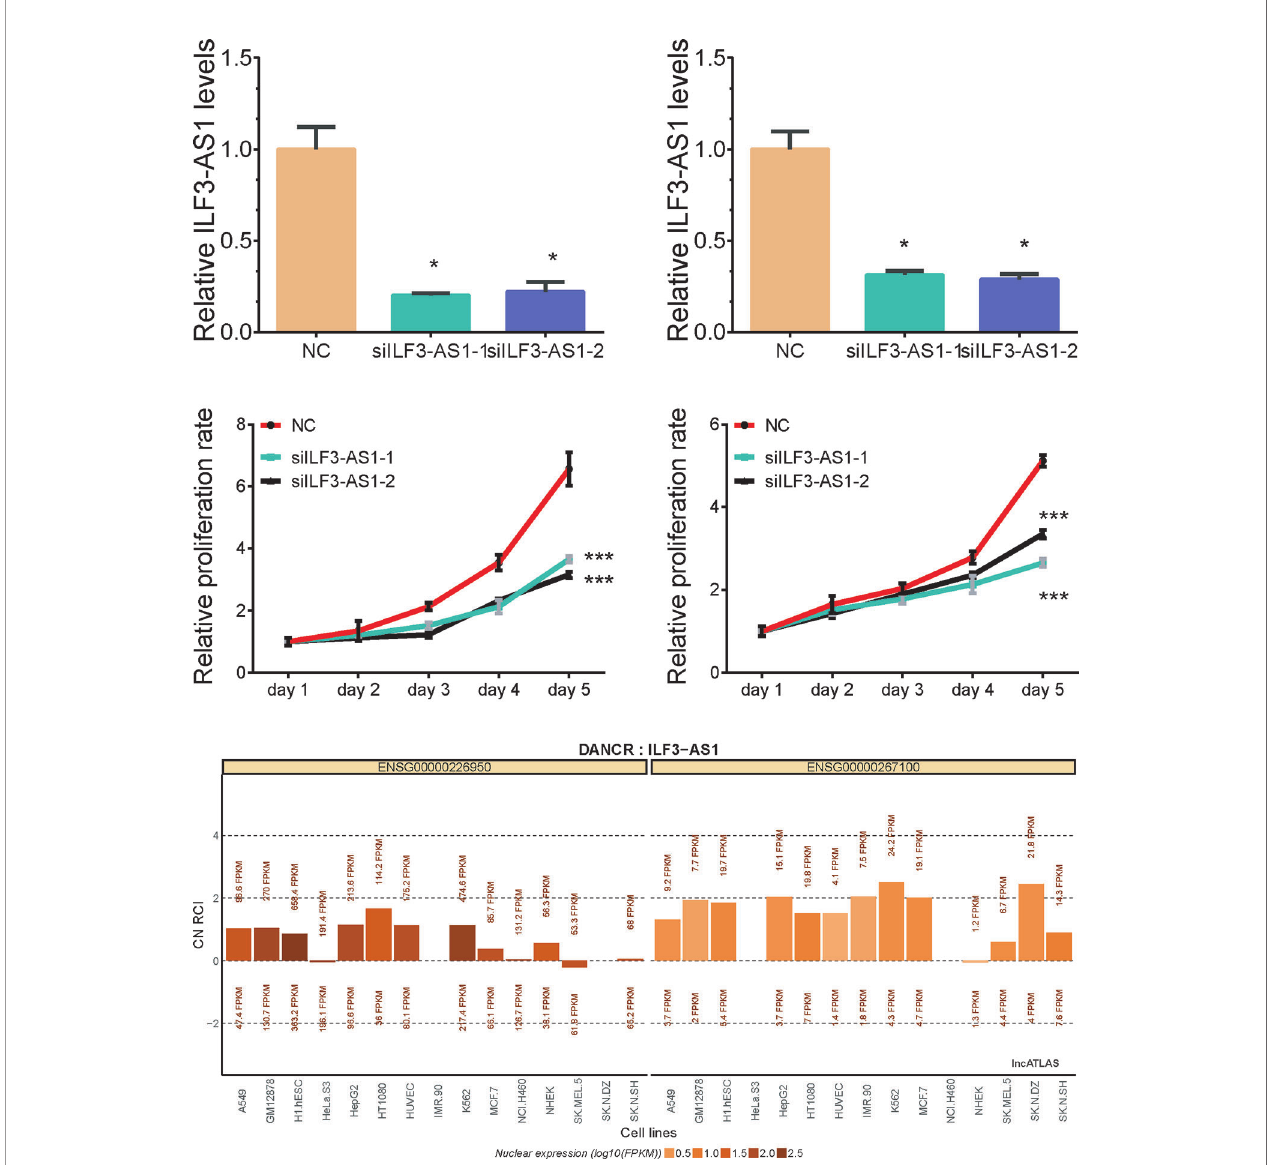
FIGURE 5 | Knockdown of ILF3-AS1 induced cell proliferation in GC. (A, B) qRT ‐ PCR assay showed Knockdown results of ILF3-AS1 in SGC-7901 and AGS cells. (C, D) Knockdown of ILF3-AS1 induced cell proliferation in SGC-7901 and AGS cells. (E) By analyzing LncATLAS dataset, we found ILF3-AS1 localized in both the cytoplasm and nuclear in most of the cell lines. Data are presented as the mean ± SD (n = 3). Signifcance was de fi ned as p < 0.05 (*p < 0.05; **p < 0.01; ***p <